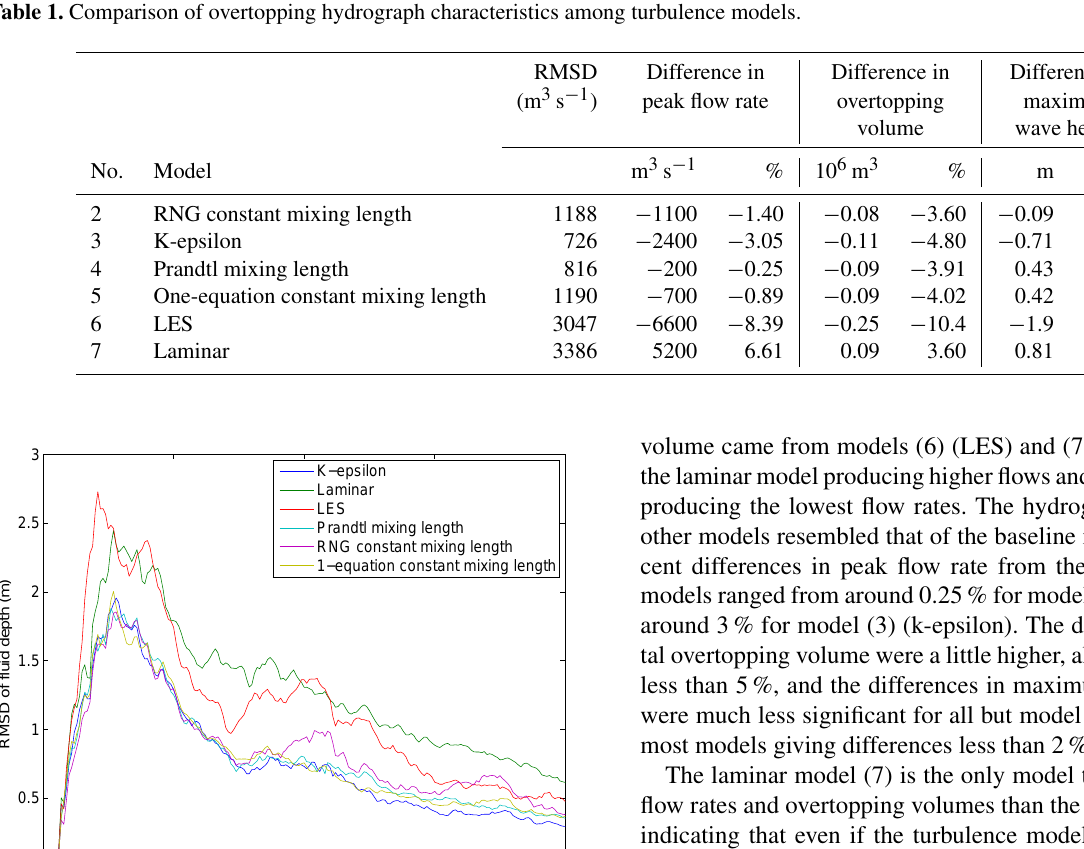
Table 1. Comparison of overtopping hydrograph characteristics among turbulence models.